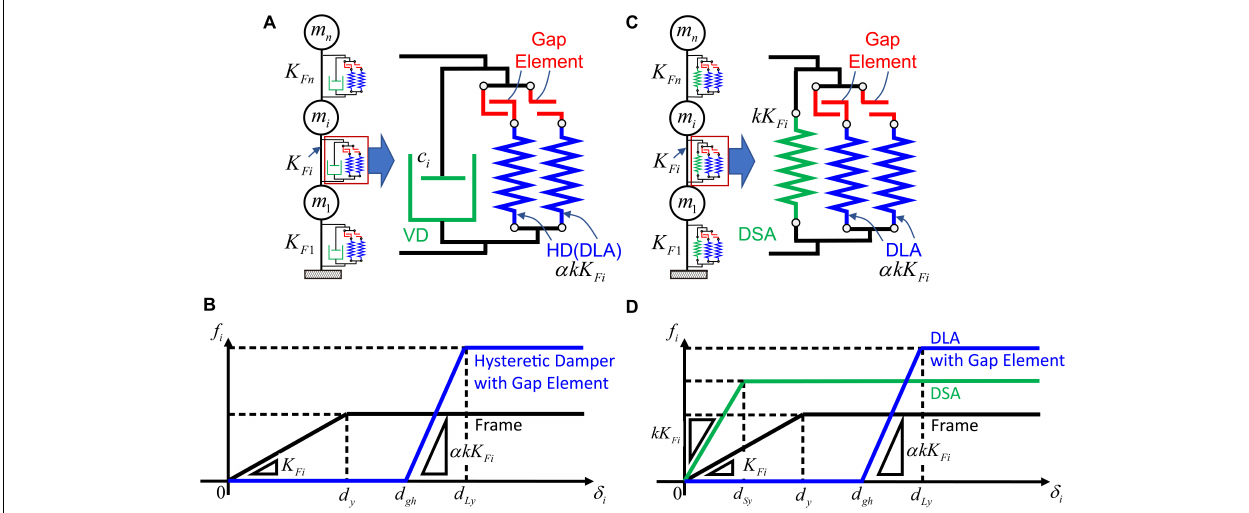
FIGURE 4 | MDOF systems with different damper systems, (A) MDOF system with HVH system, (B) Story shear force-inter-story drift relation of MDOF system with HVH system, (C) MDOF system with DHD system, (D) Story shear force-inter-story drift relation of MDOF system with DHD system.